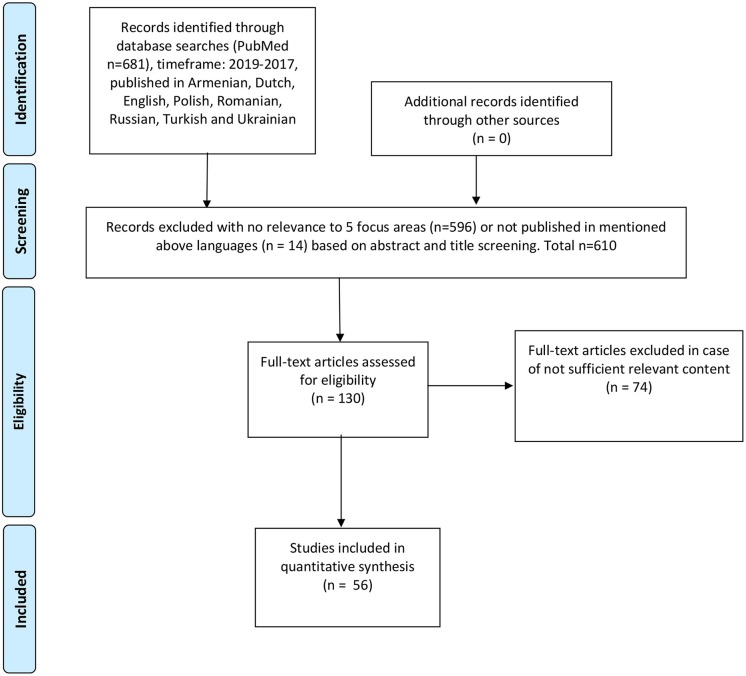
Reproduced with permission from PRISMA 2009 flow diagram (27).